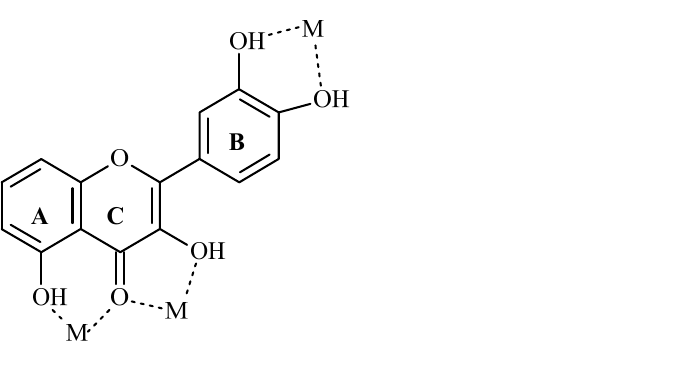
Figure 8. General structure of flavonoids with indicated sites of binding with metal ions. Complexes of Cu(II), Fe(II), Fe(III), Ni(II), Zn(II) with rutin ( 26 ) are better anti-inflammatory agents [255,256] and a complex of Mg(II) with rutin ( 26 ) is active against rat paw edema induced by serotonin. Fe(III) complex of rutin ( 26 ) suppresses lung edema [242], but it stimulated release of oxygen radicals from macrophages. Other studies indicated that complexes of Cr(III) [257], Cu(II) [258], Fe(II), Zn(II) [239], VO(IV) are better radical scavengers than